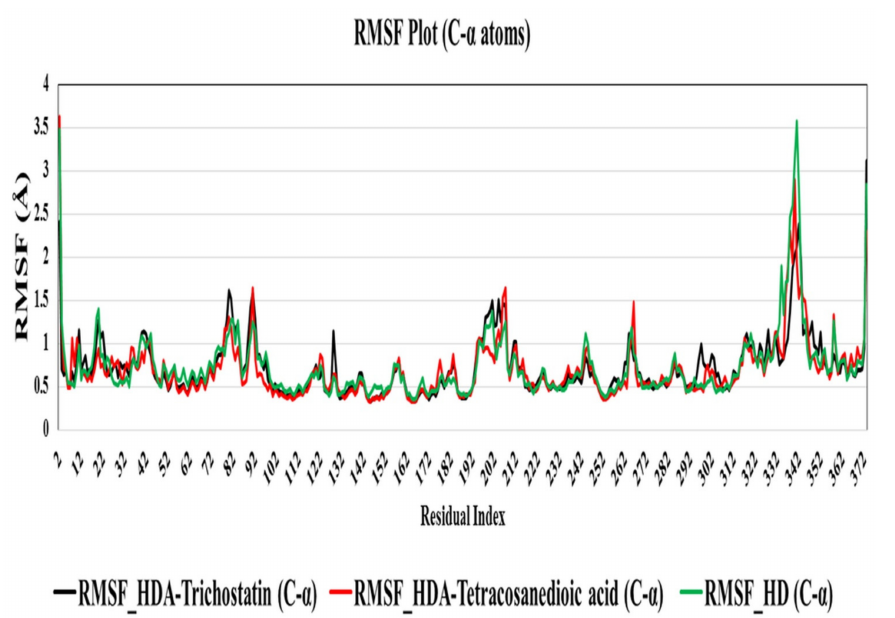
Figure 10. Tetracosanedioic acid and trichostatin A (TSA), a known inhibitor of HDAC, display the least and acceptable fluctuations in complex with HDAC. Root mean square fluctuation (RMSF) plot of HDAC in complex with trichostatin A and tetracosanedioic acid. The RMSF plot was recorded during 10 ns MD simulations. Trichostatin A is shown indicated in black, and tetracosanedioic acid is indicated in red The y-axis represents RMSF values in Angstrom. The RMSF plot of HDAC without any ligand was collected as a control. The x-axis indicates interacting amino acid residues of HDAC with tetracosanedioic acid and TSA.